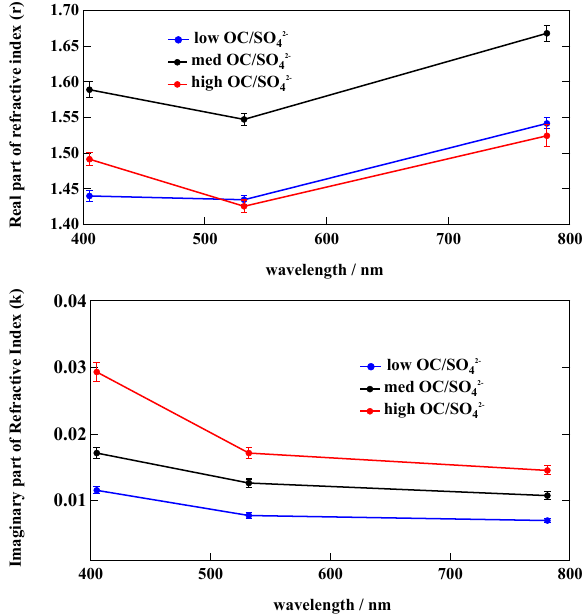
Fig. 4. Complex refractive index for calculated for low, medium, and high OC/SO 2 − episodes in CAPMEX. The color-coding is 4 analogous to Fig. 3, the high OC/SO 2 − case is in blue, the inter- 4 mediate OC/SO 2 − in black and the high OC/SO 2 − case in red. 4 4 OC mass composition data for closure and to quantify the ef- fects of mixing and processing. The mean EC and OC mass percentage of PM 2 . 5 total mass are 0.3 and 2.8% for the low case, 0.7 and 5.6% for the intermediate OC/SO 2 − OC/SO 2 − 4 4 case, and 0.7 and 7.8% for the high OC/SO 2 − case. 4